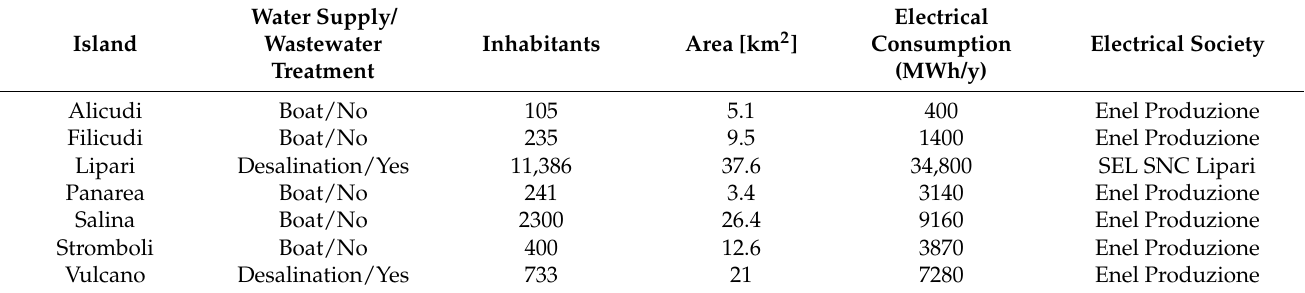
Table A4. Main data of Aeolian Island.